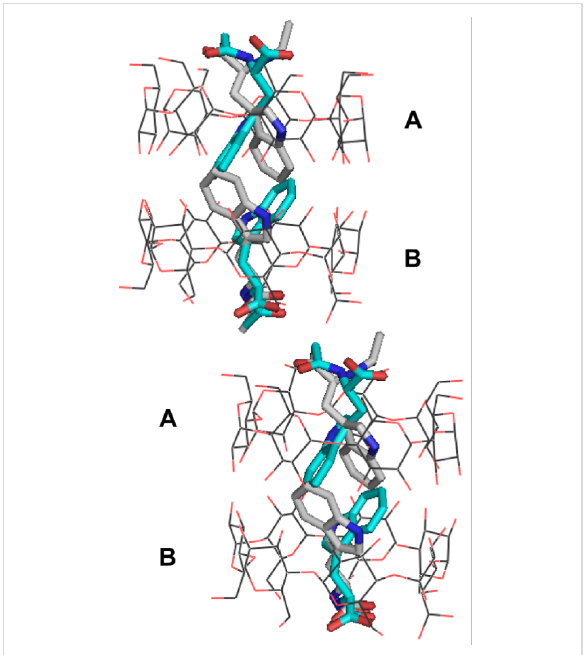
Figure 2: Two dimers of β -CD–L-NAcTrp, stacked along the a -axis, are shown. Each β -CD dimer ( A , B ) encloses a pair of guest mole- cules distributed in two orientations, the major ( C and D in cyan) and the minor ( E and F , in grey) respectively.